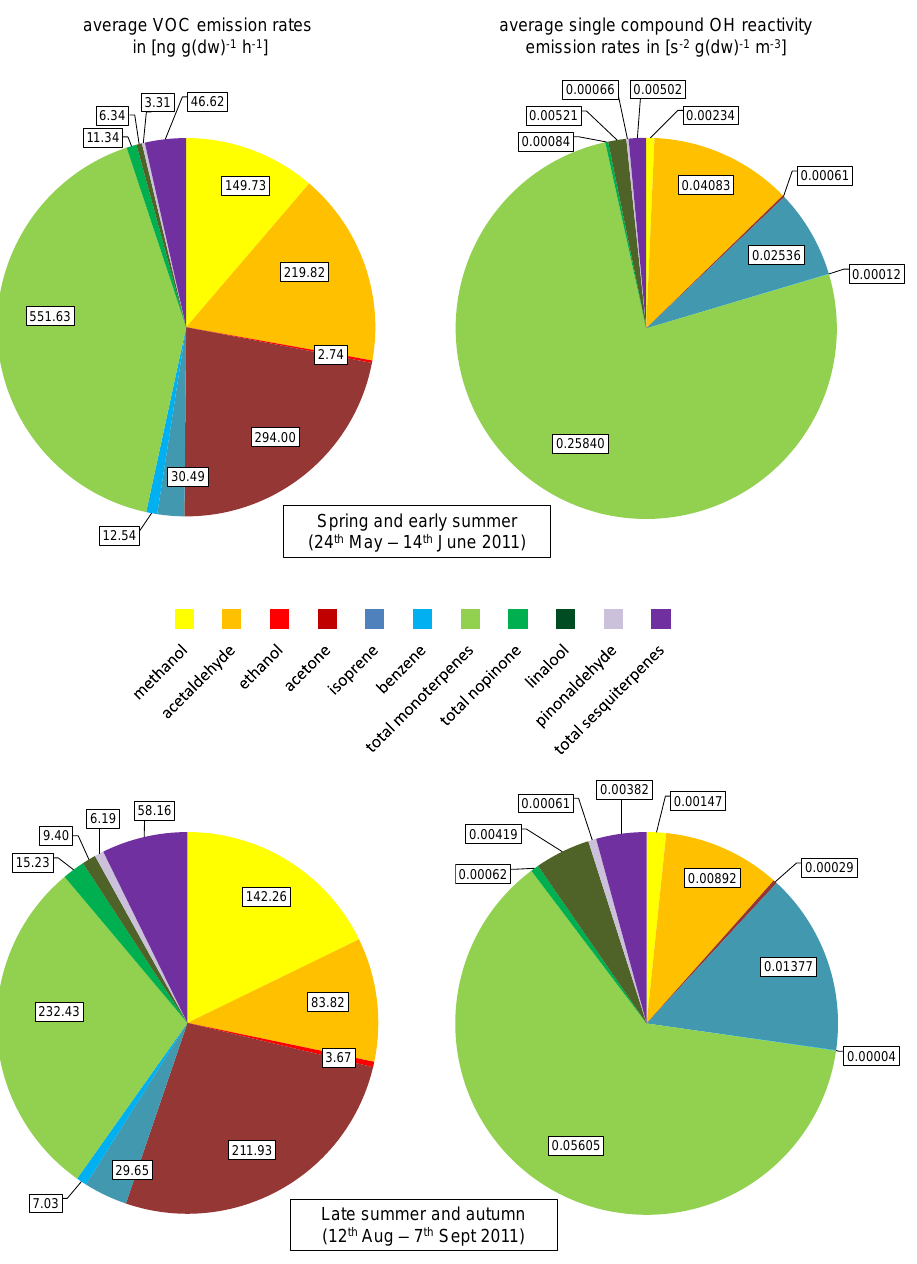
Fig. 5. On the left: average composition of biogenic VOC emissions determined by PTR-MS for both measurement periods: (top) springtime and early summer, (bottom) late summer and early autumn. Average emission rates are given in ngg(dw) − 1 h − 1 . On the right: average contribution of the VOC-PTR-MS-measured compounds to the calculated total OH reactivity emission rates. Single-compound OH reactivity emission rates are calculated from the measured concentration levels and the reaction rate coefficients given in Table 1. The single-compound OH reactivity emission rates are presented for both measurement periods: (top) springtime and early summer, (bottom) late summer and early